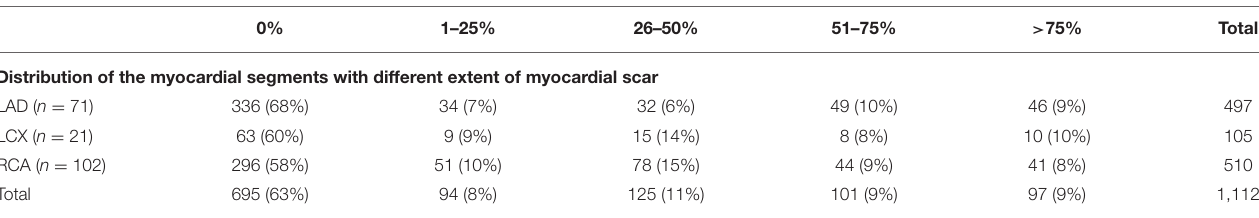
TABLE 2 | Distribution of myocardial segments in CTO territory according to scar formation.